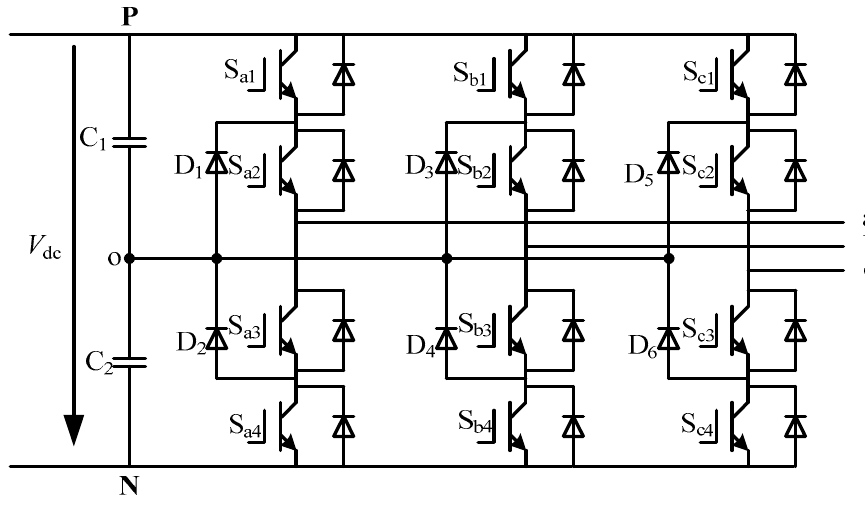
Figure 2. Topology of diode-clamped three-level converter.